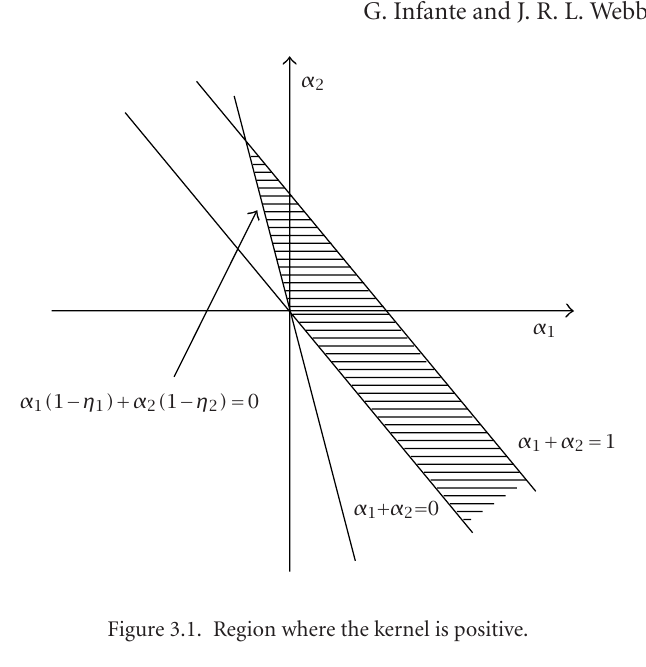
Figure 3.1. Region where the kernel is